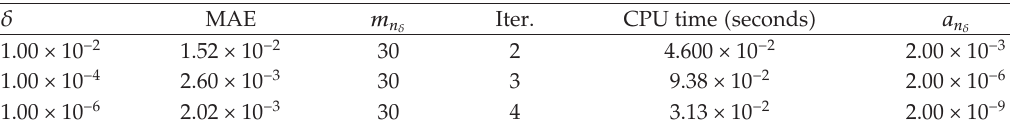
Table 7: Example